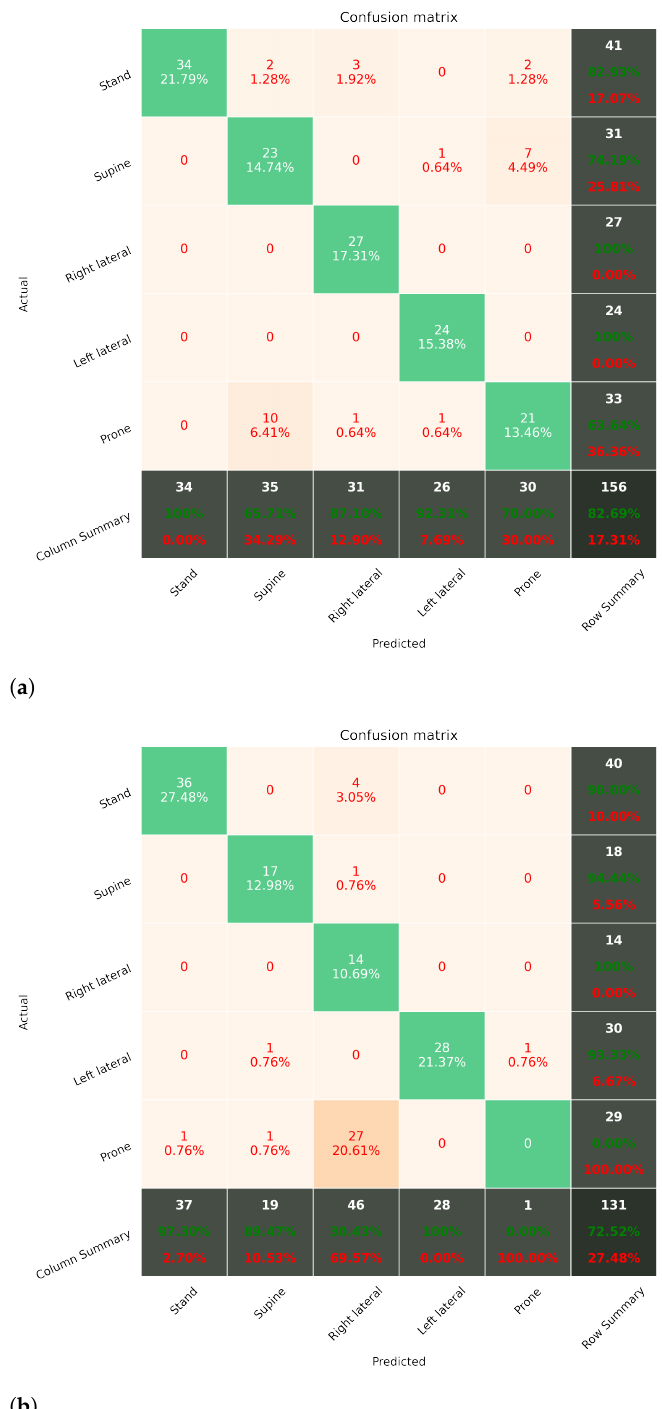
Figure 10. The prediction accuracy of adopting SVC as the learning algorithm. ( a , b ) show the confusion matrices of the prediction results of S1 and S2. The overall accuracy of the subjects are 0.82 and 0.72, respectively. ( a ) SVC with subject 1; ( b ) SVC with subject